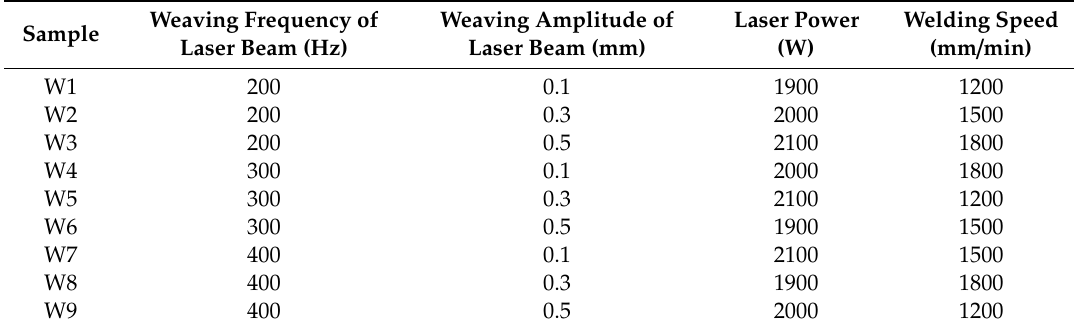
Table 3. Laser oscillating welding parameters.